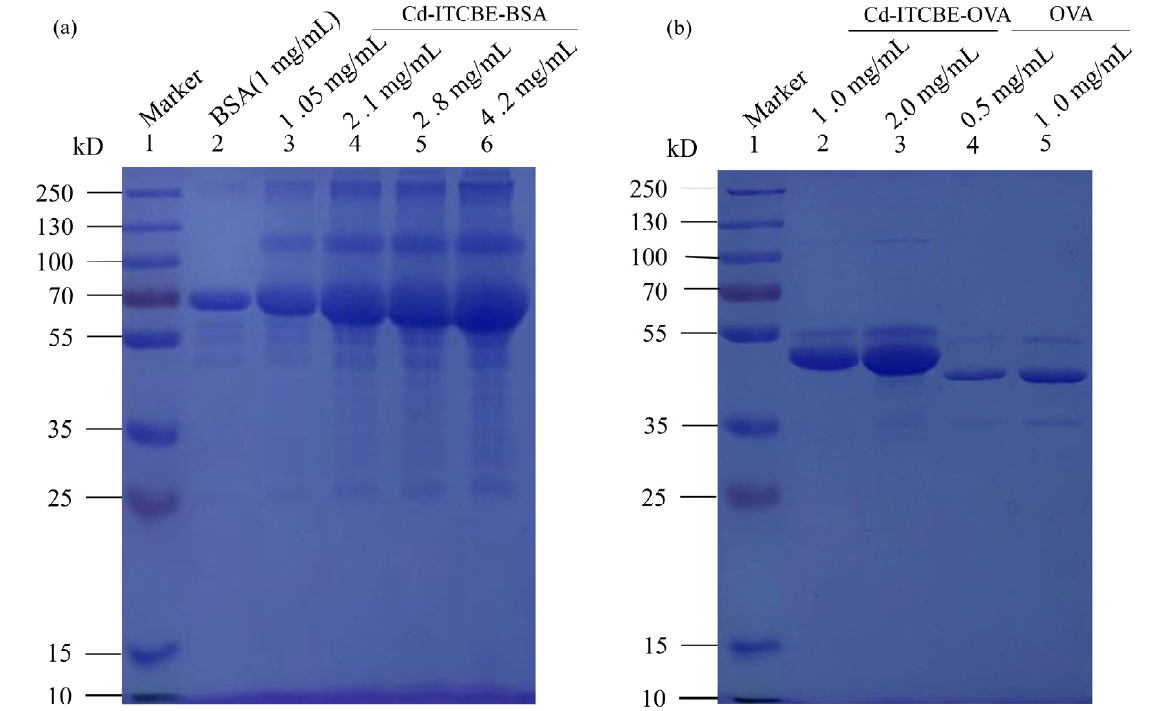
Figure 3. Sodium dodecyl dulfate polyacrylamide gel electrophoresis (SDS-PAGE) identification of Cd-ITCBE-BSA ( a ) and Cd-ITCBE-OVA ( b